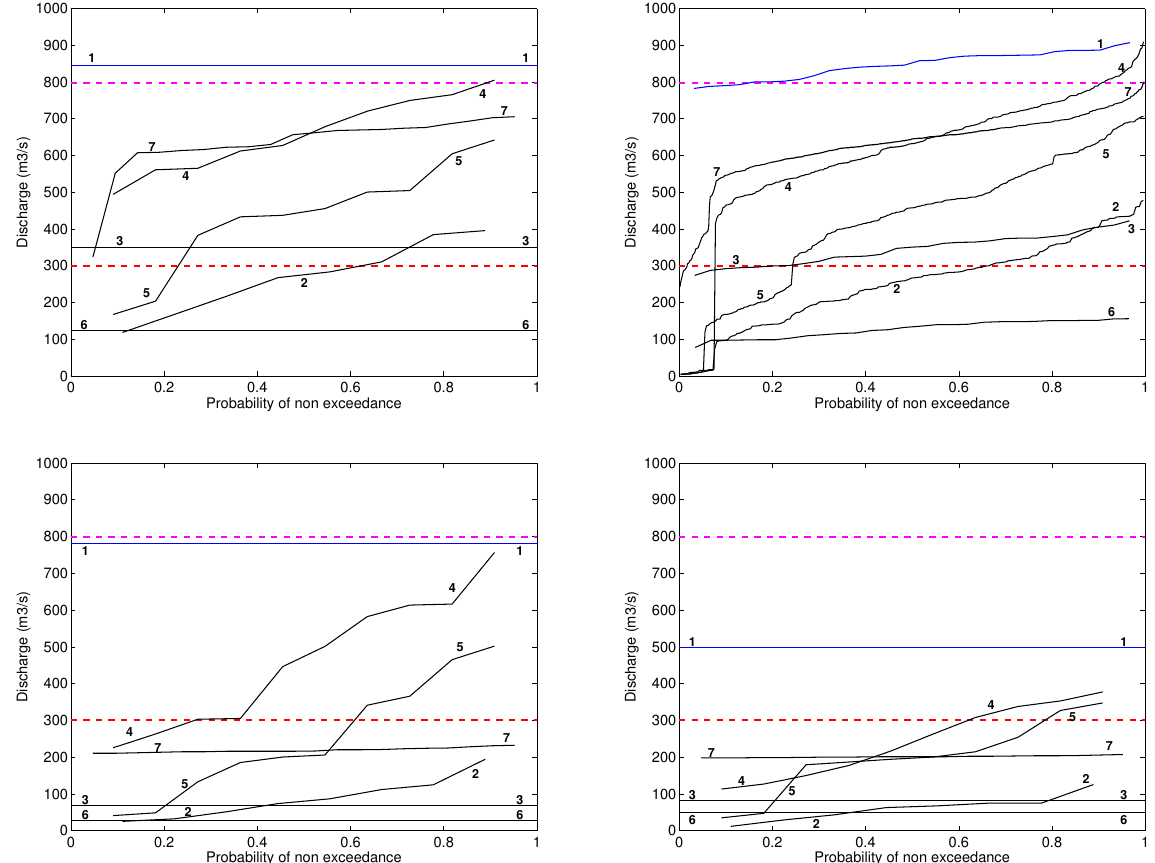
Figure 15. Summary of all results obtained with all hydrological models forced by all meteorological models. The solid line represents the estimation of the probability distribution of peak discharge for (1) observed rainfall, (2) AROME, (3) WRF-ARW, (4) MNH-ARP, (5) MNH-MWF, (6) WRF-NMM and (7) RainFARM. The red dashed line is the warning threshold and the dashed magenta line corresponds to the observed peak discharge. The upper left plot shows results for the RIBS deterministic simulation, the upper right plot results for the RIBS probabilistic simulation, the lower left plot results for a DRiFt deterministic simulation and the lower right plot results for an HBV deterministic